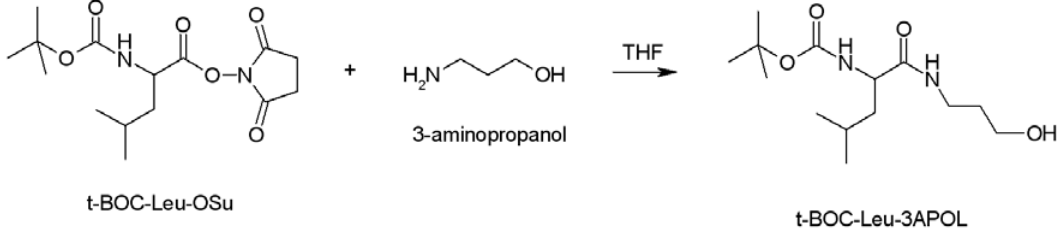
Fig. 2 Synthetic route leading to the attachment of the linker to leucine, the first C-terminal amino acid in the sequence of